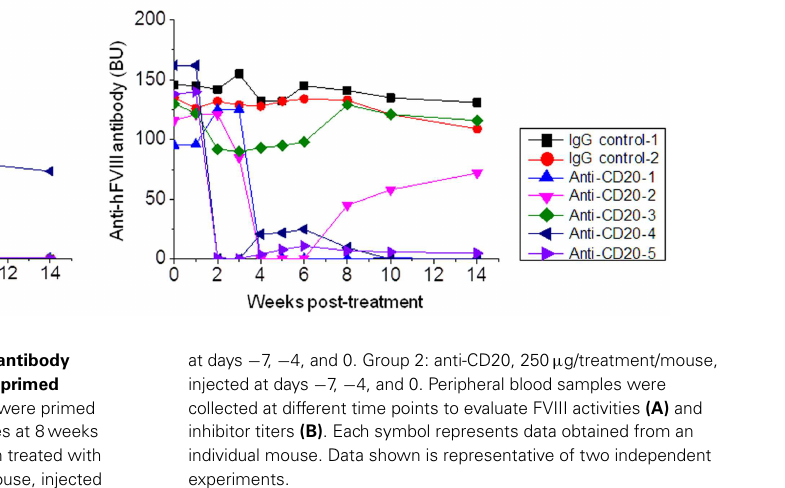
at days − 7, − 4, and 0. Group 2: anti-CD20, 250 µ g/treatment/mouse, injected at days − 7, − 4, and 0. Peripheral blood samples were collected at different time points to evaluate FVIII activities (A) and inhibitor titers (B) . Each symbol represents data obtained from an individual mouse. Data shown is representative of two independent